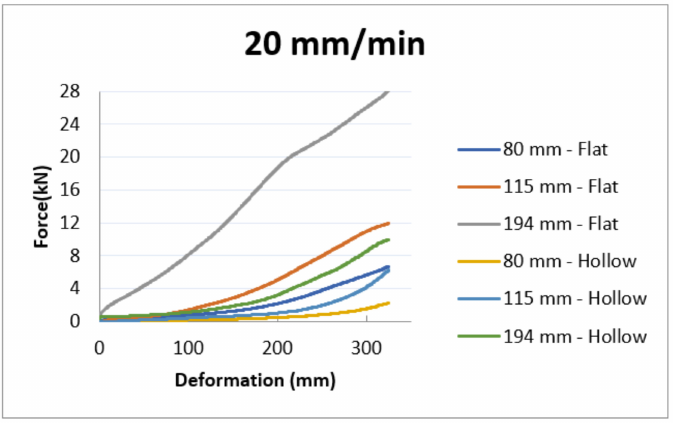
Figure 15. Deformation and force at each position for a speed of 20 mm/min. Next, a comparison of the three speeds is shown for each tube and type (H or F) (Figures 16–18).